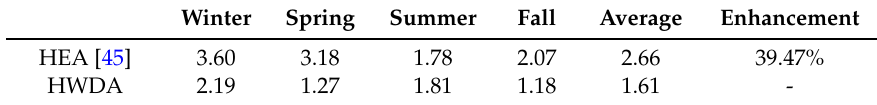
Table 9. NRMSE (the normalized root mean square error) comparison for wind power